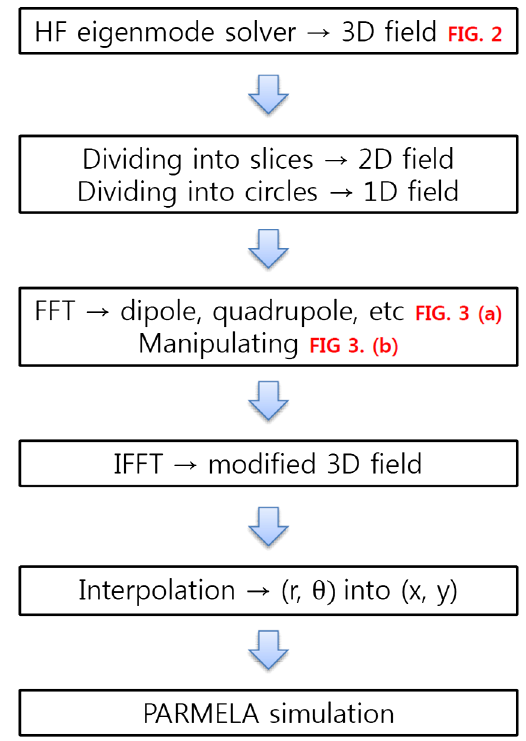
FIG. 13. The process of